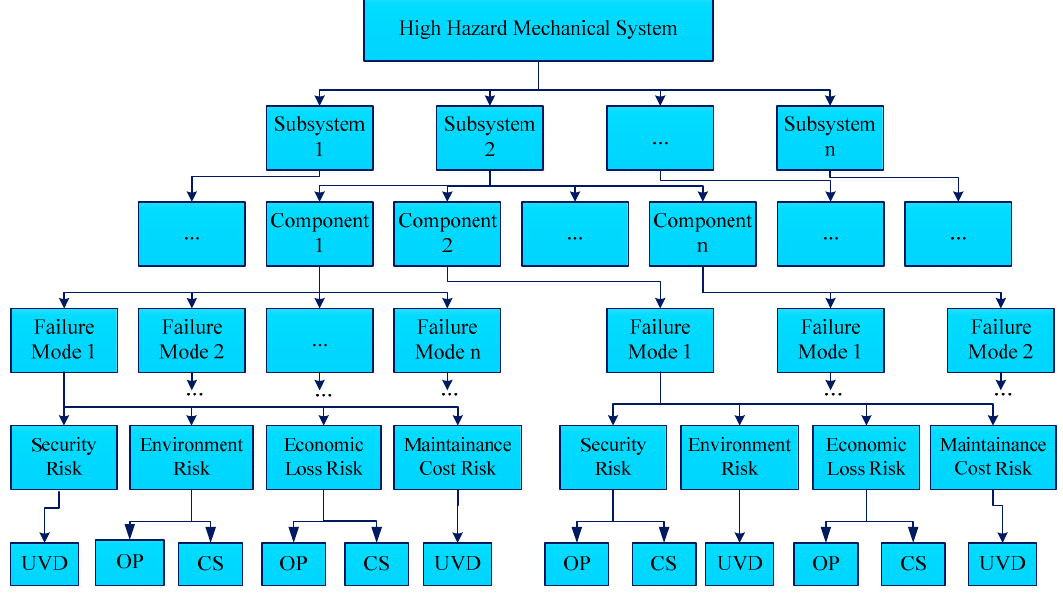
Figure 1. The hierarchical structure tree (HST) of a conventional high-hazard mechanical system (HHMS). UVD: uncertain and vague data; OP: occurrence probability; CS: consequence severity.